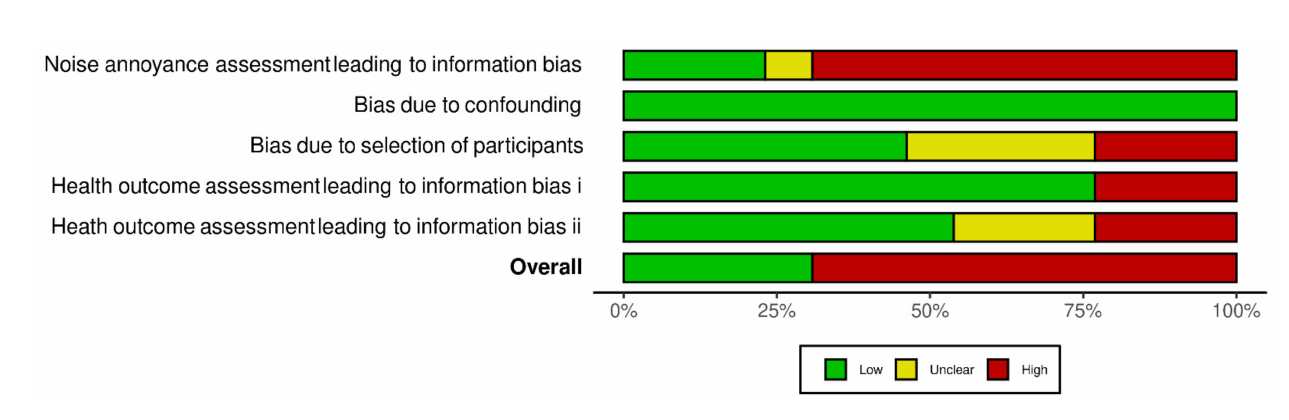
Figure A1. Summary of the risk of bias assessments.